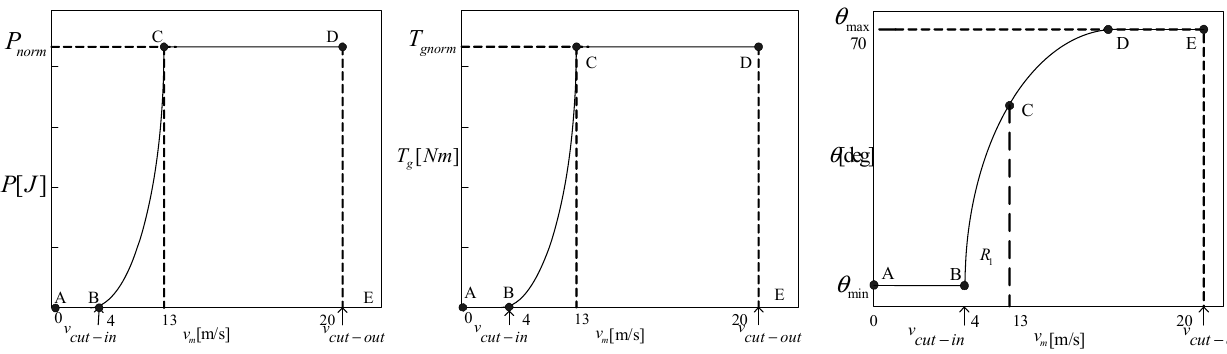
and (cid:1842) following the wind (cid:3034) (cid:3034)